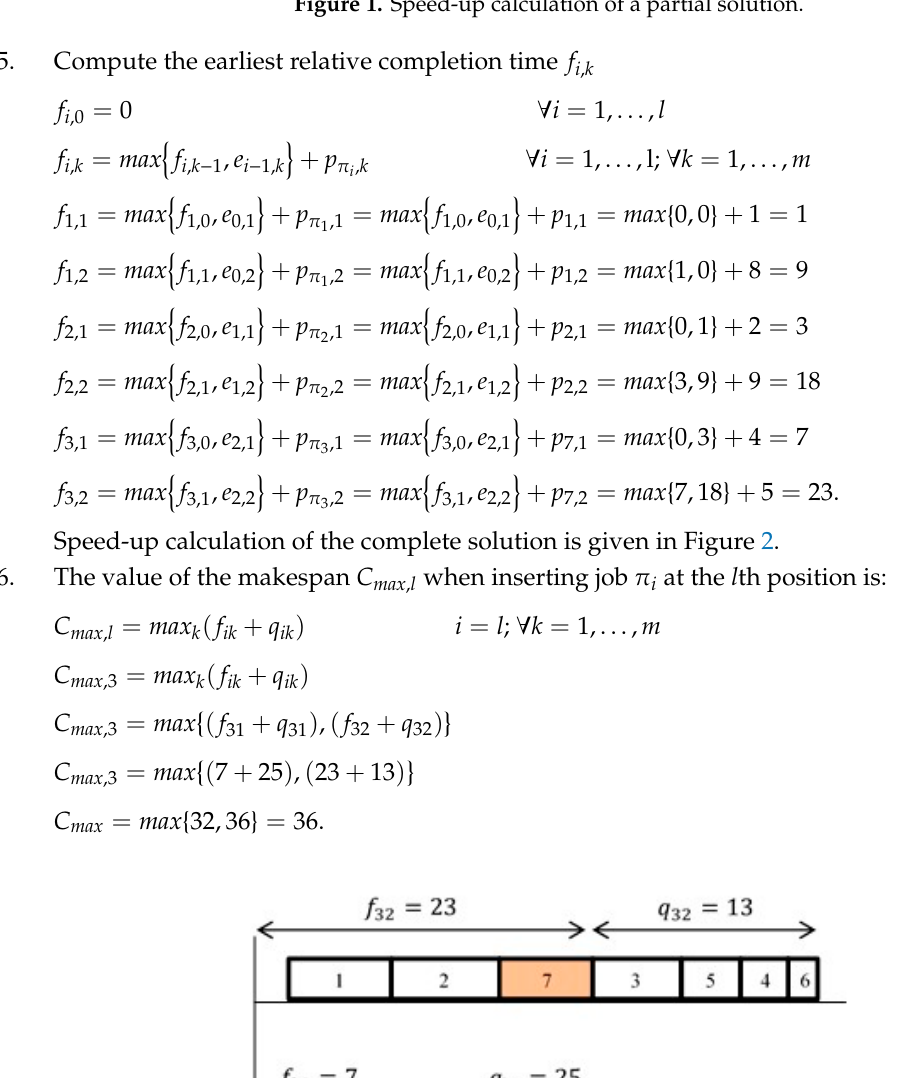
Figure 1. Speed-up calculation of a partial solution.